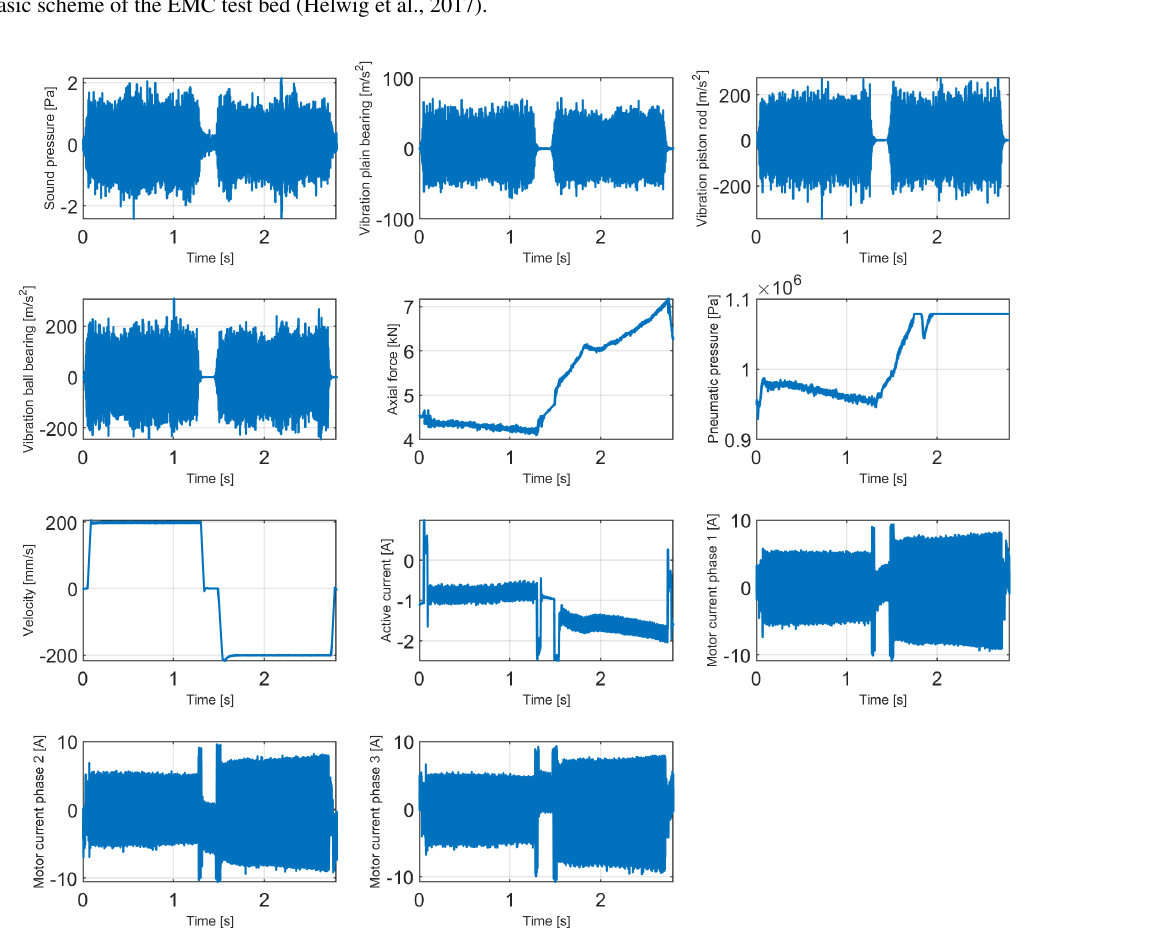
Figure 2. Raw data recorded during one cycle by 11 sensors expressed in SI units.